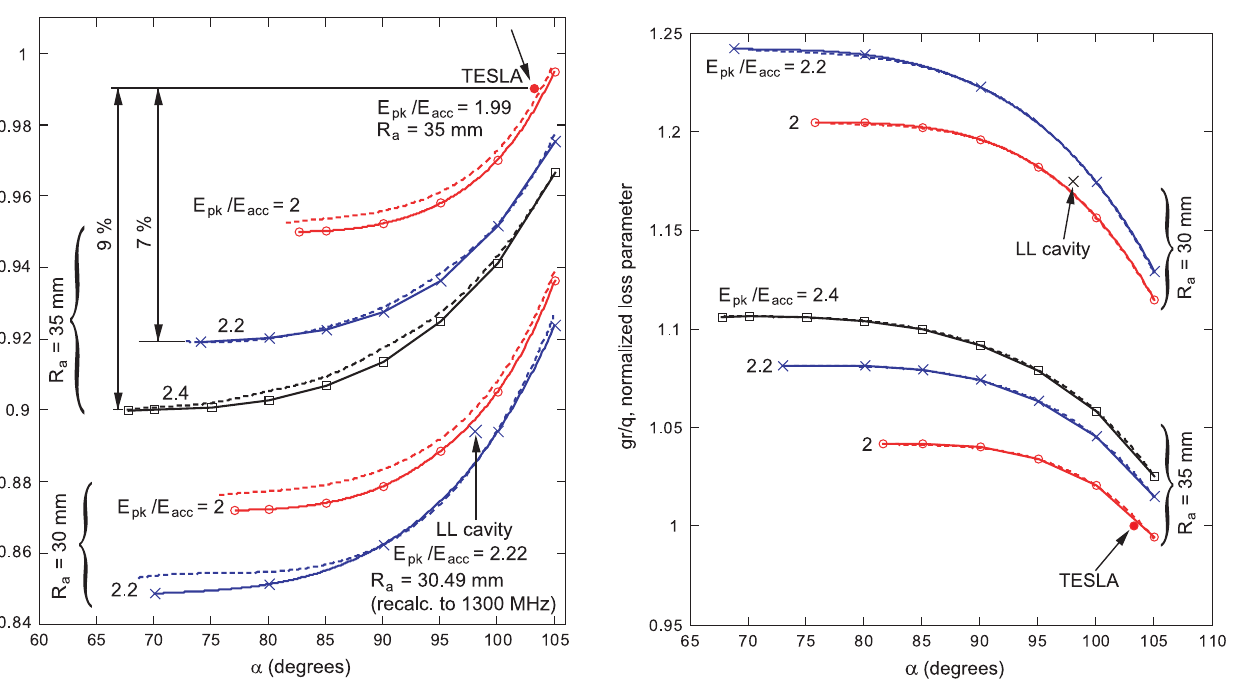
FIG. 2. (Color) Normalized magnetic peak field for different angles of slope. Solid lines present optimization for min h , dash lines are for max G (cid:1) R sh =Q .